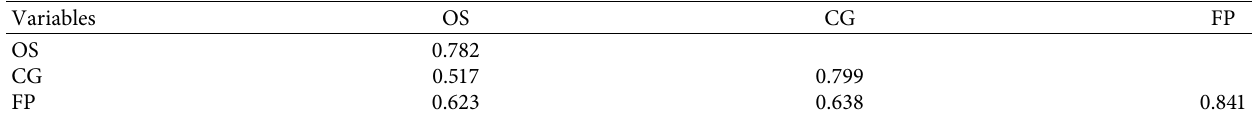
Table 7: Fornell–Larker matrices for divergent validity.